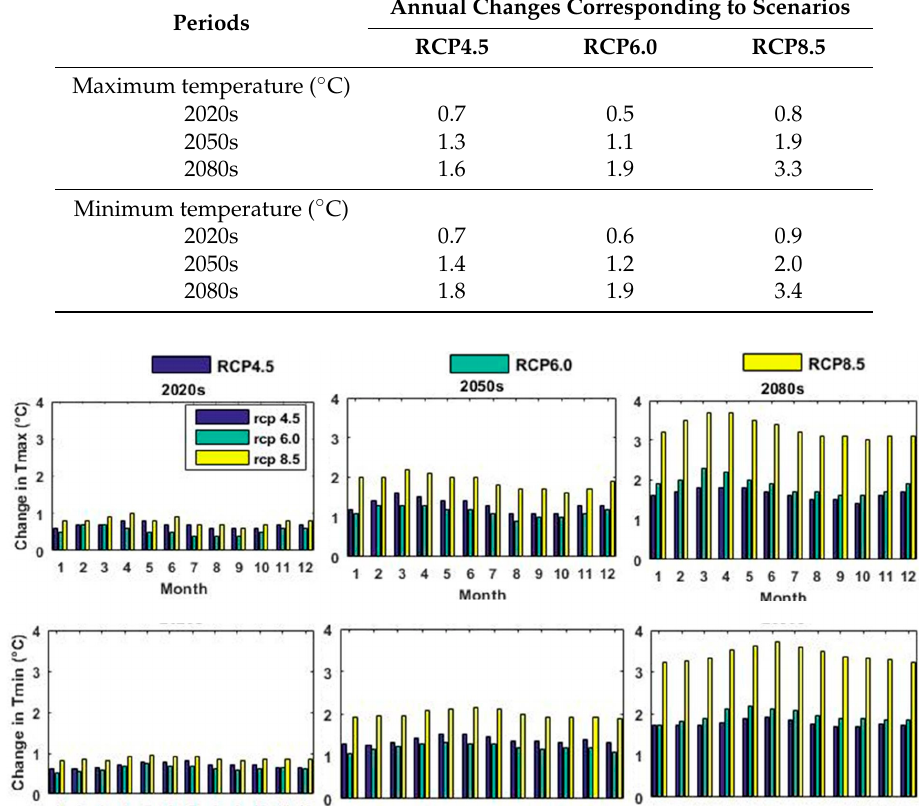
Table 3. Annual changes in future t max , t min and rainfall under the RCP45, 60 and 85 scenarios. Annual Changes Corresponding to Scenarios Periods